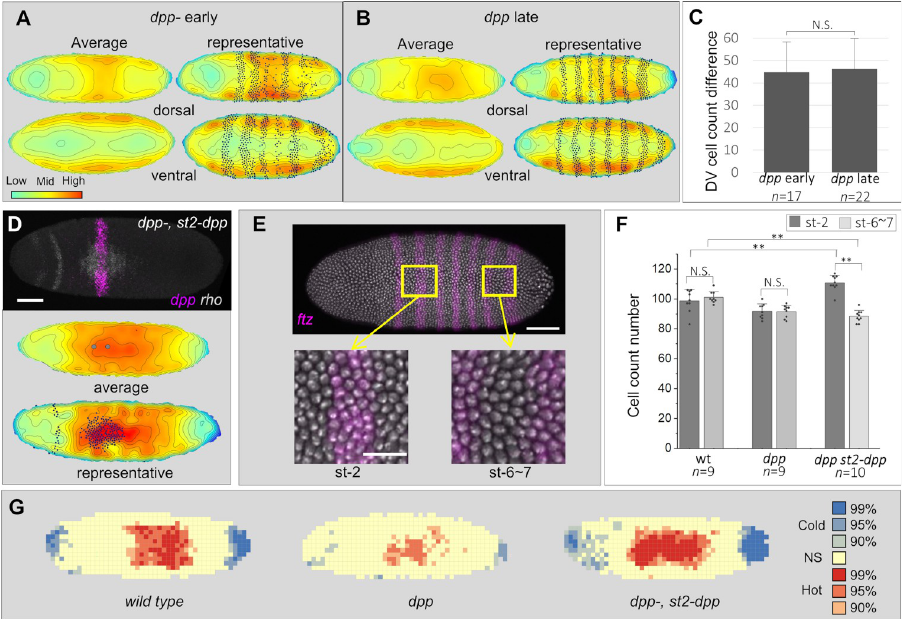
Fig 2. DPP pulls cells over long distances. Cell density heatmaps of dpp- embryos at early (A) and late (B) cellularization stages. The dorsal surface has slightly higher density than ventral surface that does not change over time. Average heatmap shown on left ( n = 9). Representative heatmap on right shows ftz stripes (black dots). (C) Cell number differences between ventral and dorsal sides in dpp- at early and late stages. (D) Cell density heatmaps of the dorsal surface of late stage dpp- embryos ectopically expressing dpp ( st2-dpp )(gray dots, stripe position). Black dots in representative heatmap show rho -expressing cells. (E) Selected regions for cell counts using ftz as an A/P landmark for nearby (st-2) and distant (st-6~7) regions from ectopic dpp .(F) Cell counts in late-stage wild type and dpp- and dpp- , st2-dpp embryos. Note that st2-dpp expression increases the density of cells in ftz stripe 2 and reduces the density of cells between stripes 6 and 7 compared to wild type. Error bars, standard deviation. N.S., not significant. Asterisks, threshold values based on p -values ( �� p < 0.01) calculated with two-tail Mann–Whitney test (different stages in C; genotype comparisons in F) or two-tailed Wilcoxon signed-rank test (st-2 and st-6~7 comparisons of same genotypes in F). (G) Hot spot analysis of dorsal surface of wild type, dpp and dpp , st2-dpp embryos. Legend on left side indicates color-code for confidence intervals of hot spots (red shades) and cold spots (blue shades), and nonsignificant regions (NS, yellow). Scale bars, 60 μ m(D and E, top) and 20 μ m(E, bottom). Metadata for the graphs shown in C and F can be found at Supporting information S1 Metadata.A/P, antero-posterior; DPP, decapentaplegic; FTZ, fushi tarazu; ST2, even skipped stripe